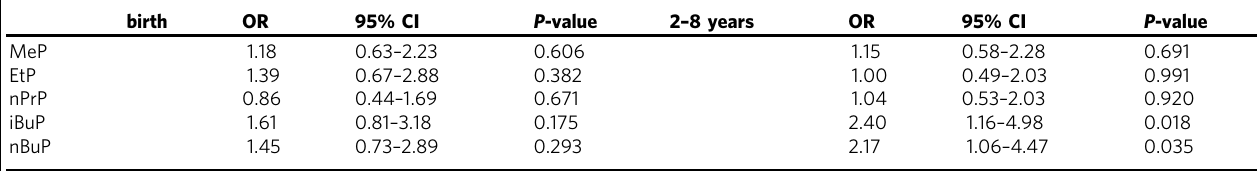
Table 2 Prenatal paraben exposure and weight development of children.